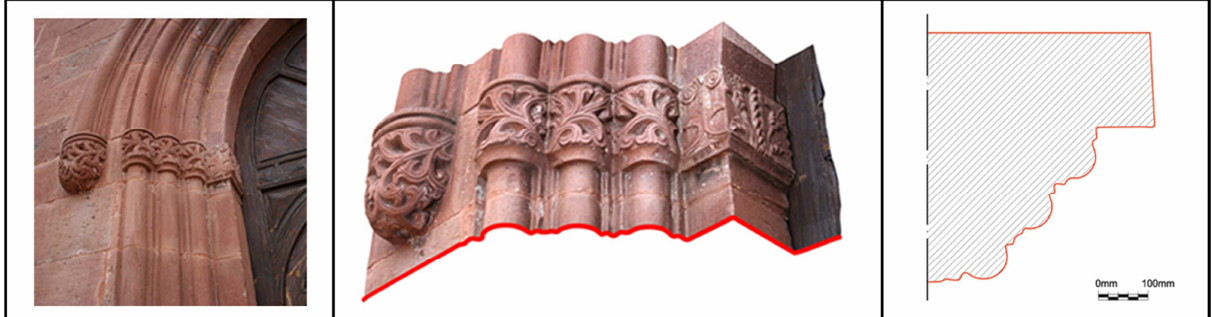
Figure 9. Portal of Santo Spirito, Allai (OR): photographic image; model 123D Catch; reconstruction of the flat section.